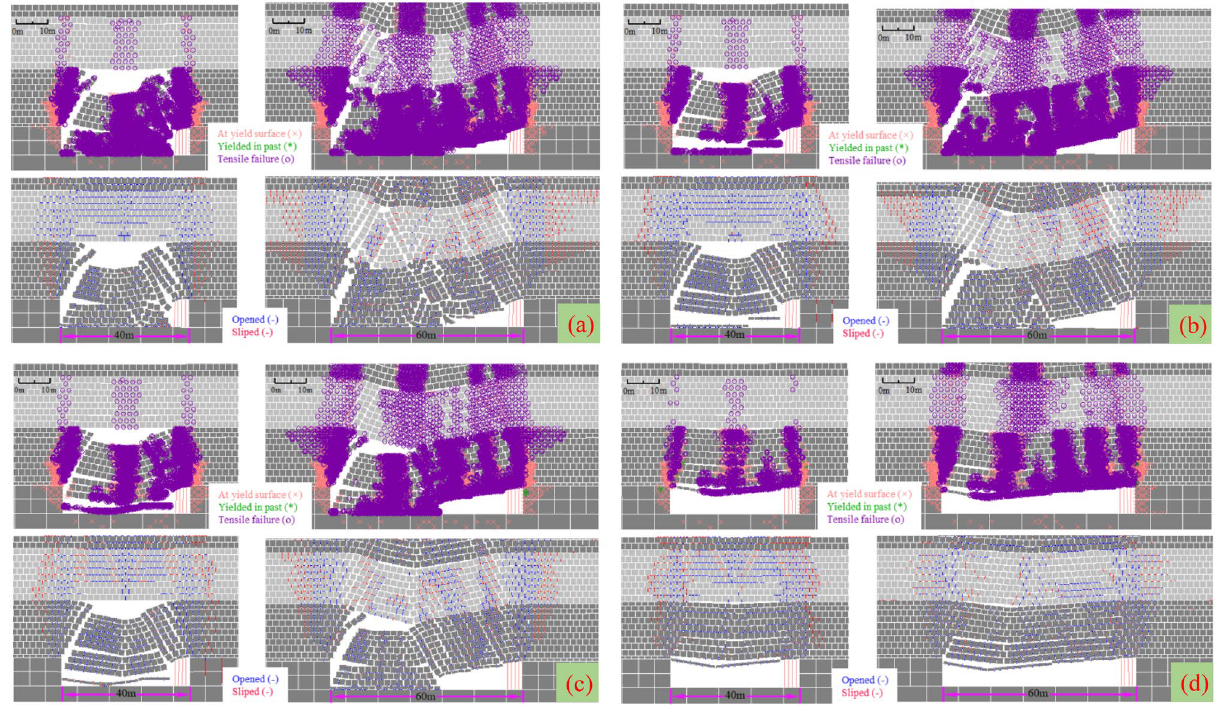
Figure 17. Mining damage degree with different advancing speed. ( a ) 5 m/d. ( b ) 10 m/d. ( c ) 15 m/d. ( d ) 20 m/d.